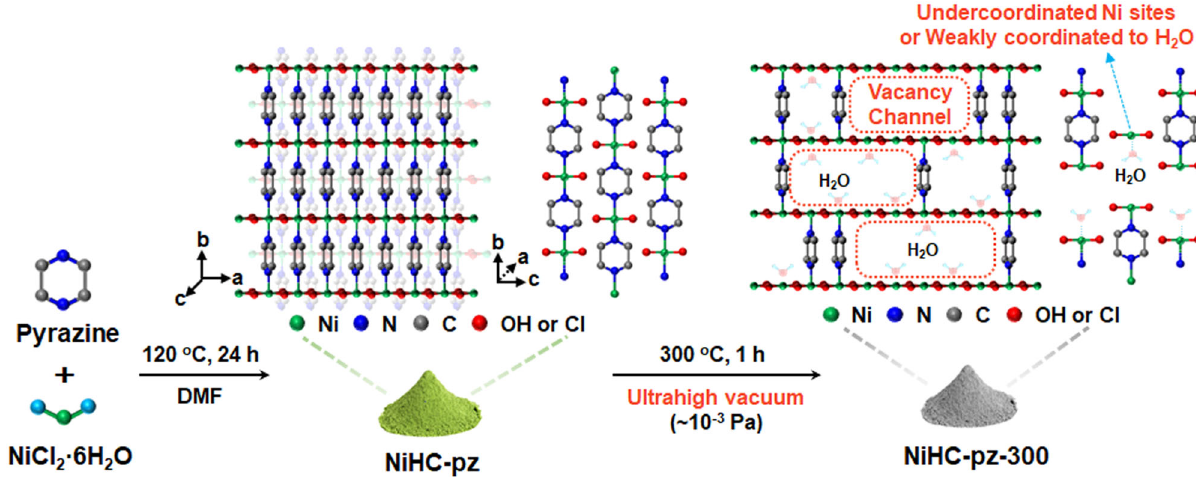
Fig. 1 | Schematic illustration of the catalyst preparation and structure. Schematic illustration of the synthesis and structure of NiHC-pz and NiHC-pz-300.